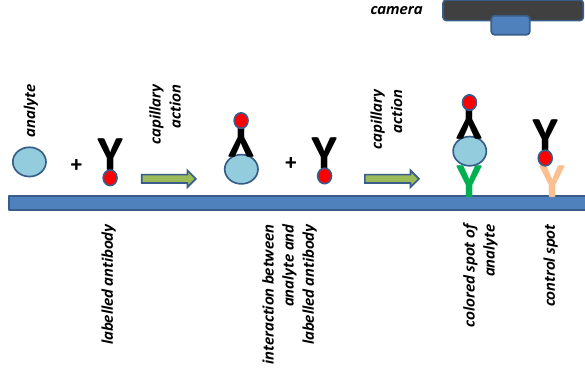
Figure 4 General principle of lateral flow immunoassay with digital camera on the